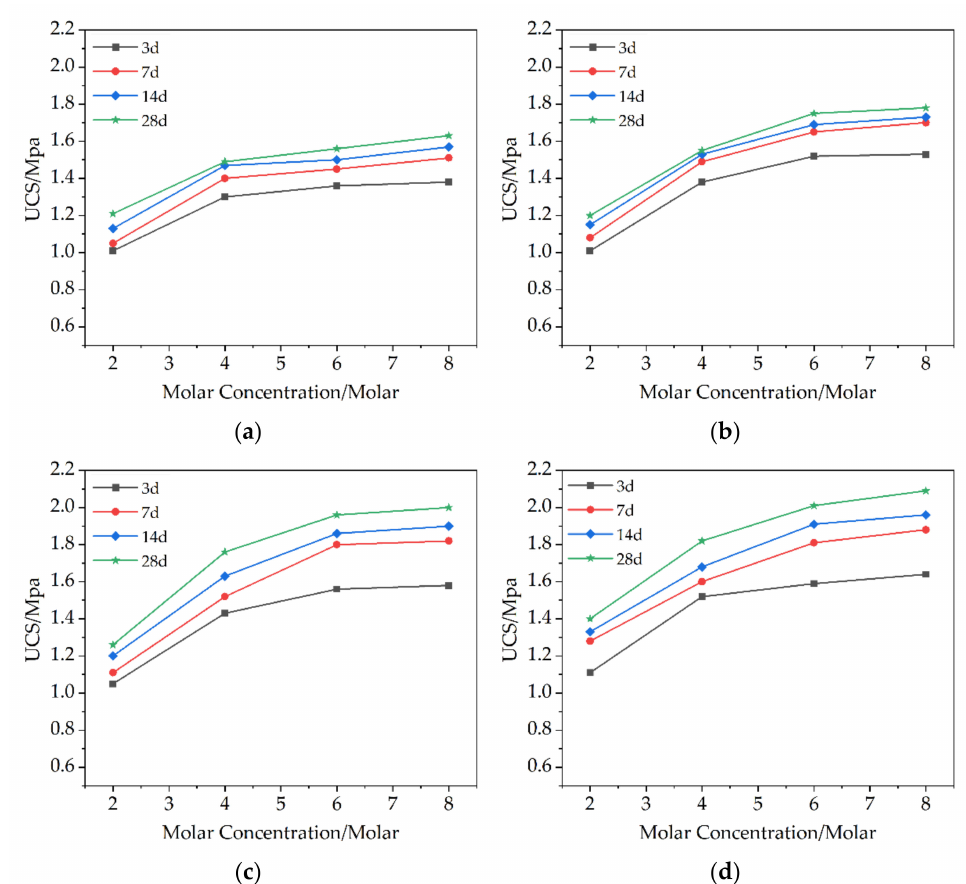
Figure 3. UCS values of different MKG contents: ( a ) result for 6% content of MKG; ( b ) result for 8% content of MKG; ( c ) result for 10% content of MKG; ( d ) result for 12% content of